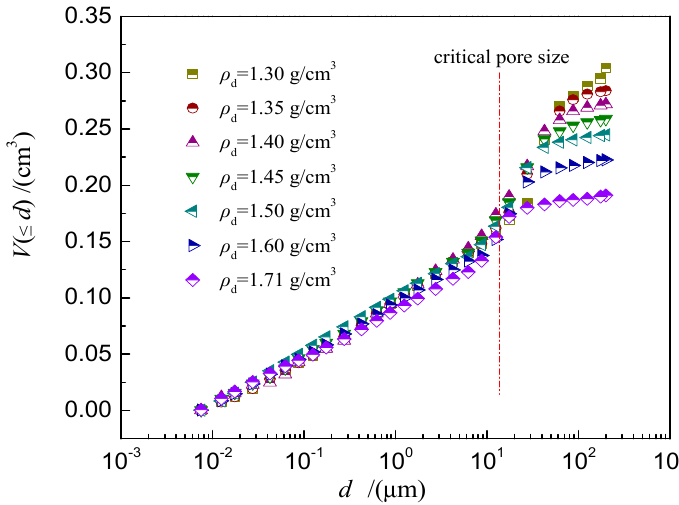
Figure 5. The cumulative pore volume curves of different dry densities